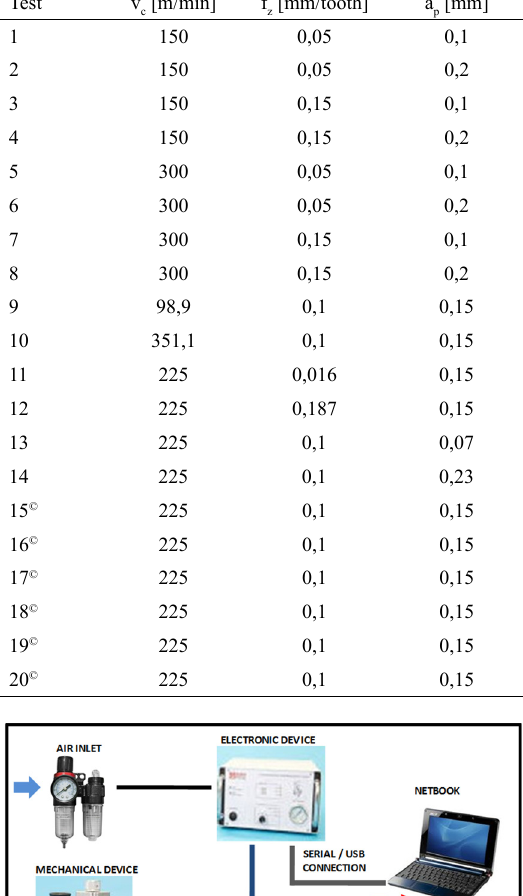
Figure 1. Setup assemble showing the axes configuration used for the residual stresses tests. Table 2. Cutting parameters and experimental design